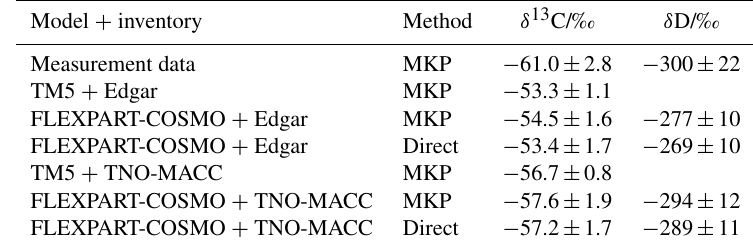
Table 3. Mean value and standard deviation of the histograms of the source isotopic composition shown in Fig. 10.